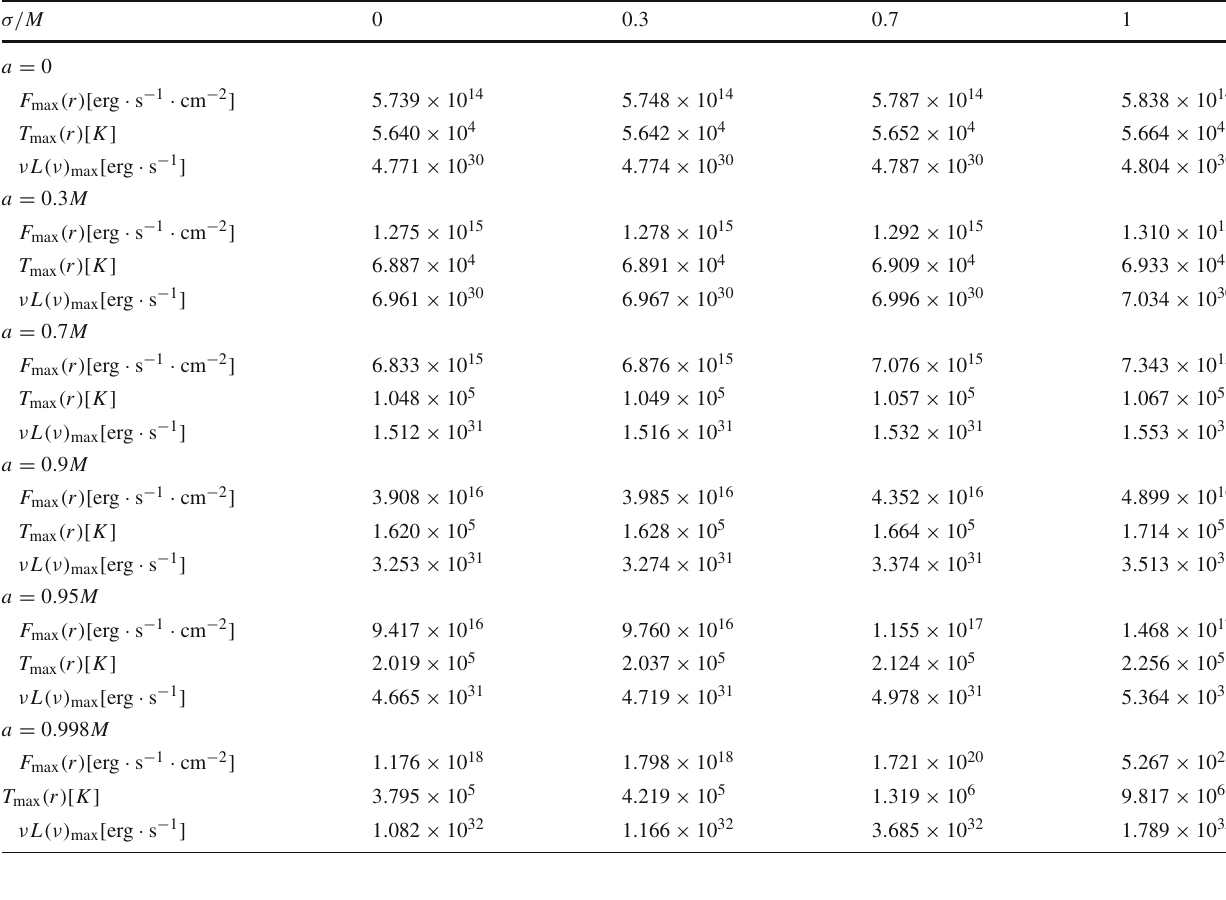
Table 2 The exact maximum values of the time averaged radiation flux F max ( r ) , temperature T max ( r ) and the emission spectra ν L (ν) max for accretion disk around BG naked singularity. The table shows the Kerr maximum values ( σ = 0) in the first column for comparison σ/ M 0 0 .